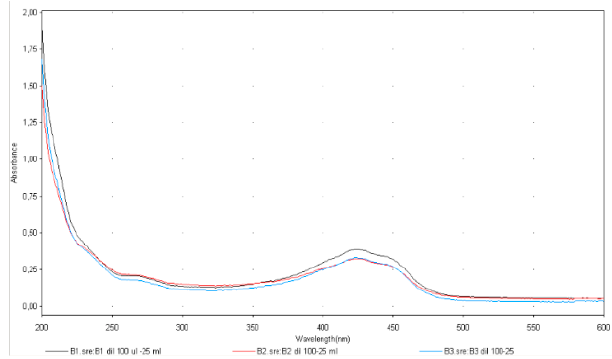
Figure 1. UV–Vis spectra of samples B1–B3.